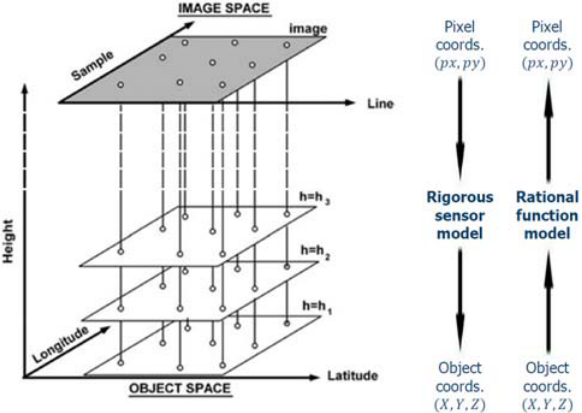
Figure 4. RPC computation (Grodecki and Dial, 2003) With the given parameters of the rigorous model and by projecting evenly distributed image points into the object space, multiple-layer 3D object points can be computed and used as virtual (fictitious) control points. The control points are created based on the full extent of the image and the range of elevation variation in the object space. The entire range of elevation variation is sliced into several layers. Then, the RPCs are calculated by a least squares adjustment with these virtual control points (Tao and Hu,